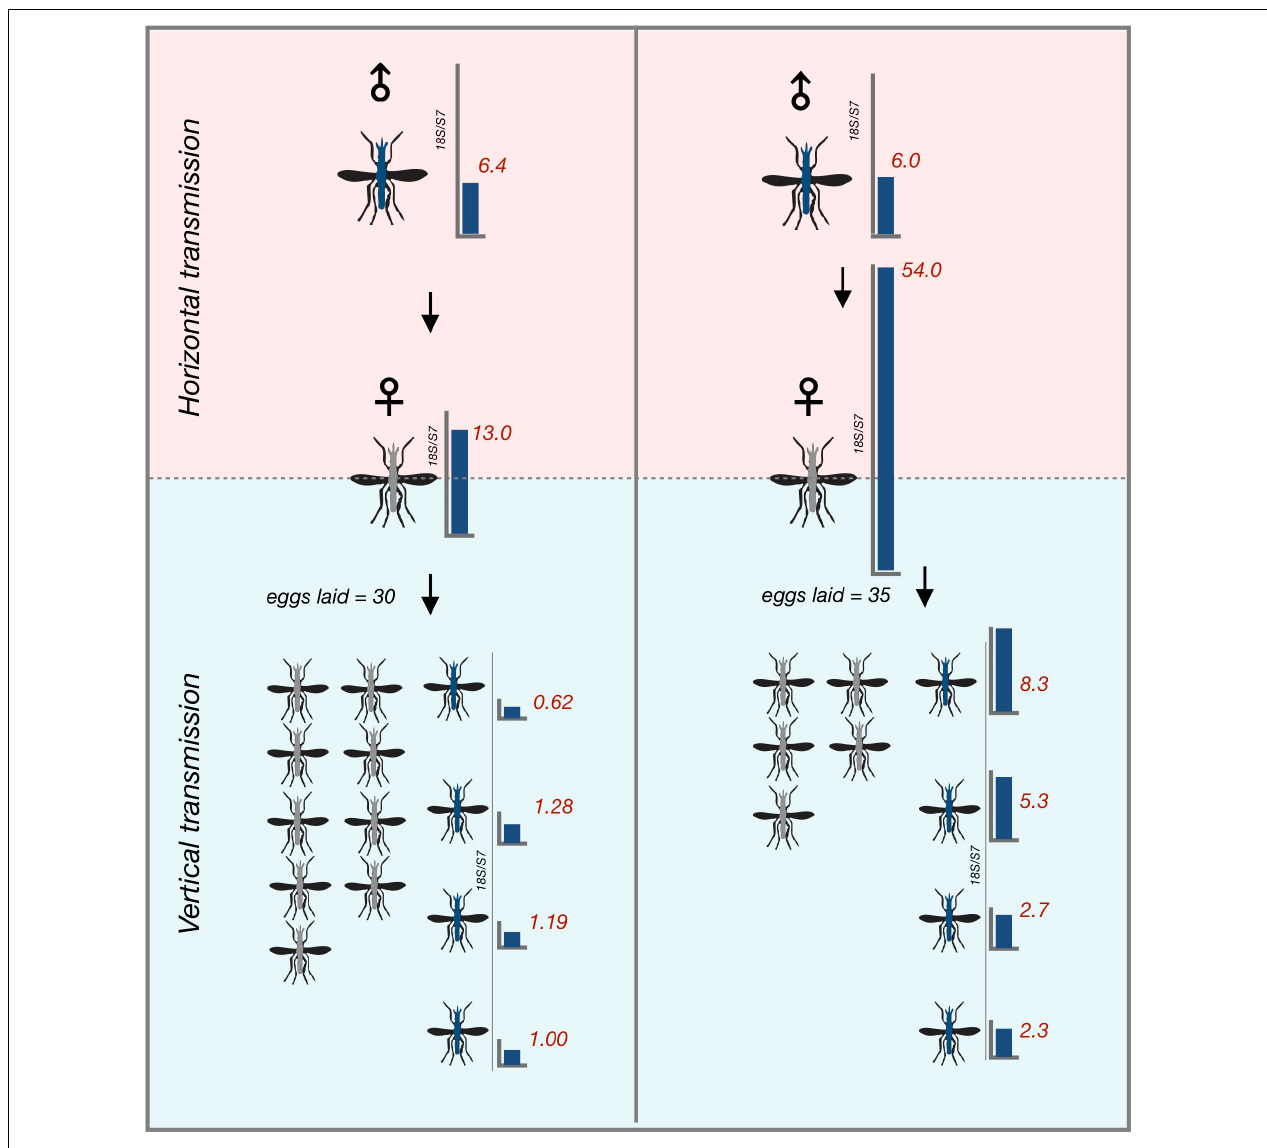
FIGURE 4 | Vertical transmission of horizontally acquired Microsporidia MB infections in An. arabiensis . Vertical transmission of Microsporidia MB is observed in recipient females that have become infected with Microsporidia MB after being kept with Microsporidia MB infected donor males in the first gonotrophic cycle after horizontal acquisition. Red numbers indicate Microsporidia MB infection intensity in individual An. arabiensis adults as determined by